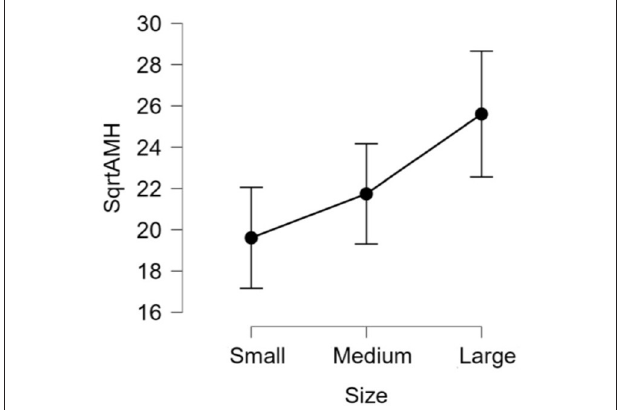
FIGURE 3 | The 95% confidence interval of the mean for each group. The data was transformed into square root of AMH (sqrtAMH) to satisfy the normal distribution assumption. Ovary size: Small = (4.5 ± 1.06), Medium = (6.7 ± 0.6), Large = (9.5 ± 1.6). The differences in all level are significant ( p -value = 0.00919). AMH, anti-Müllerian